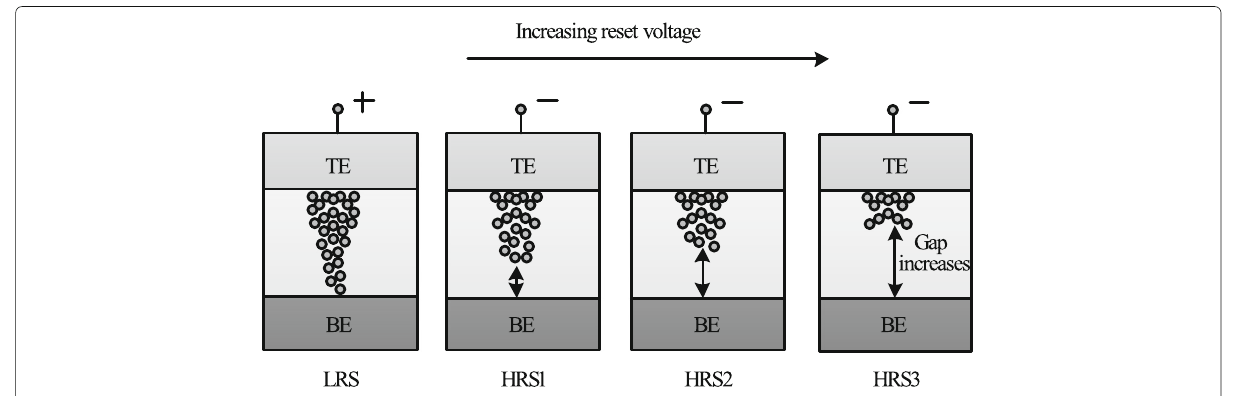
Fig. 14 Schematic illustration of multiple resistance states in RRAM cell obtained by varying reset voltage ‘V reset ’